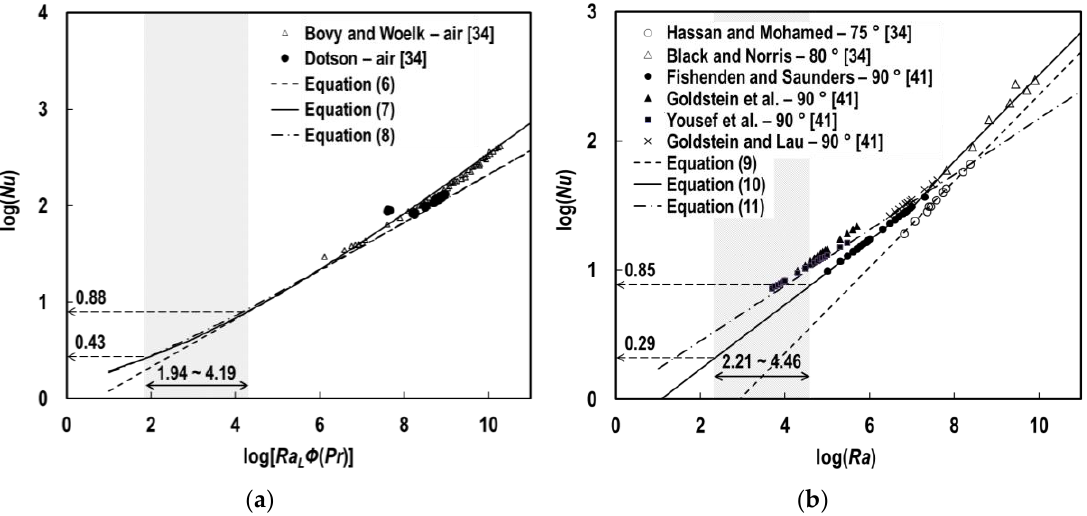
Figure 8. Ra – Nu relationships for free convection from uniformly heated, ( a ) vertical, and ( b ) inclined and horizontal plates, to air.